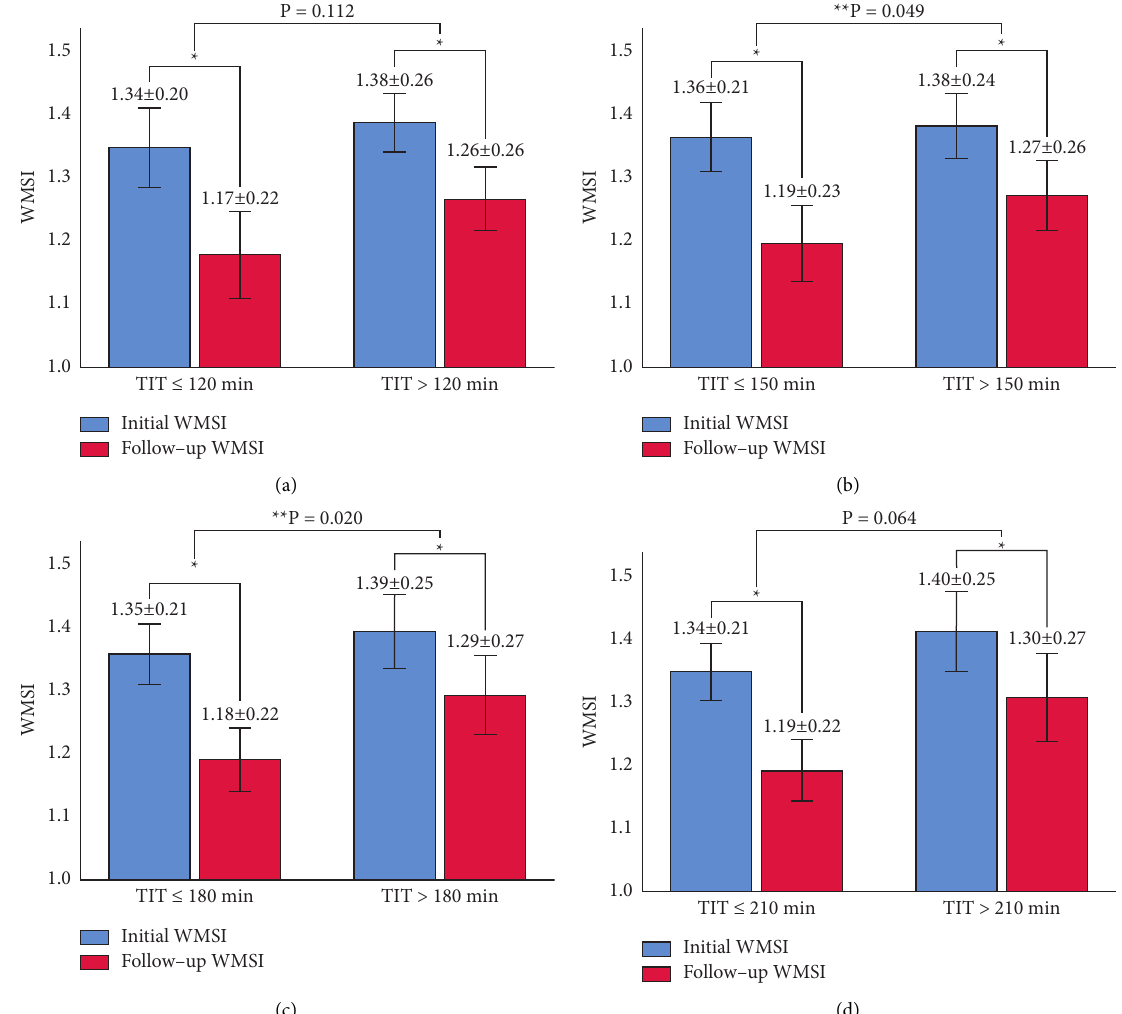
Figure 2: Changes in the WMSI value based on TITs of (a) 120, (b) 150, (c) 180, and (d) 210 minutes. TIT � total ischemic time; WMSI � wall motion score Table 3: Variables associated with a decrease in the WMSI value among patients with TITs of 180 minutes or less ( N � 74). Δ WMSI ↓ ( n � 55) Δ WMSI ↑ ( n � 19) p value